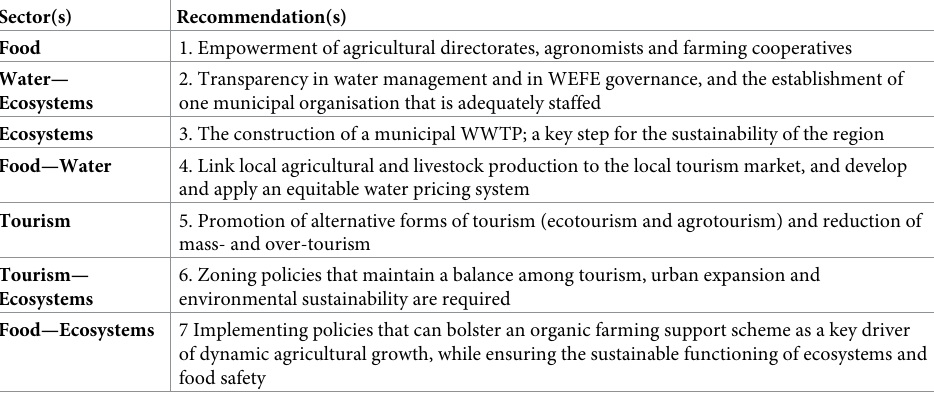
Table 2. FGs recommendations for addressing natural resources sustainability problems in